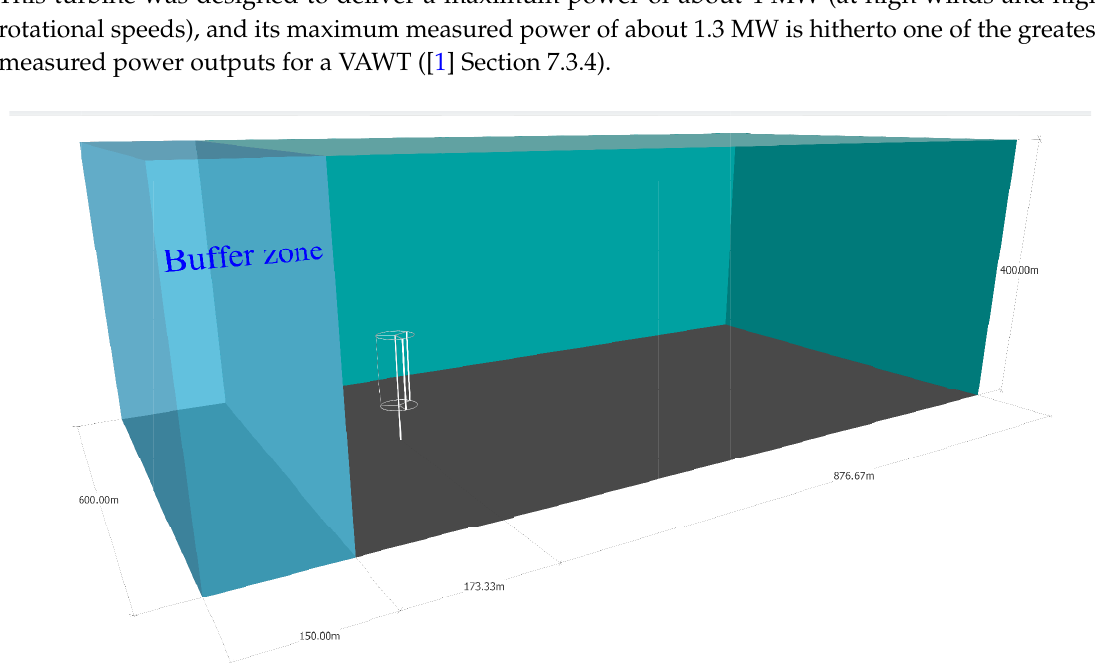
Figure 1. Schematic of the computational domain, including the simulated